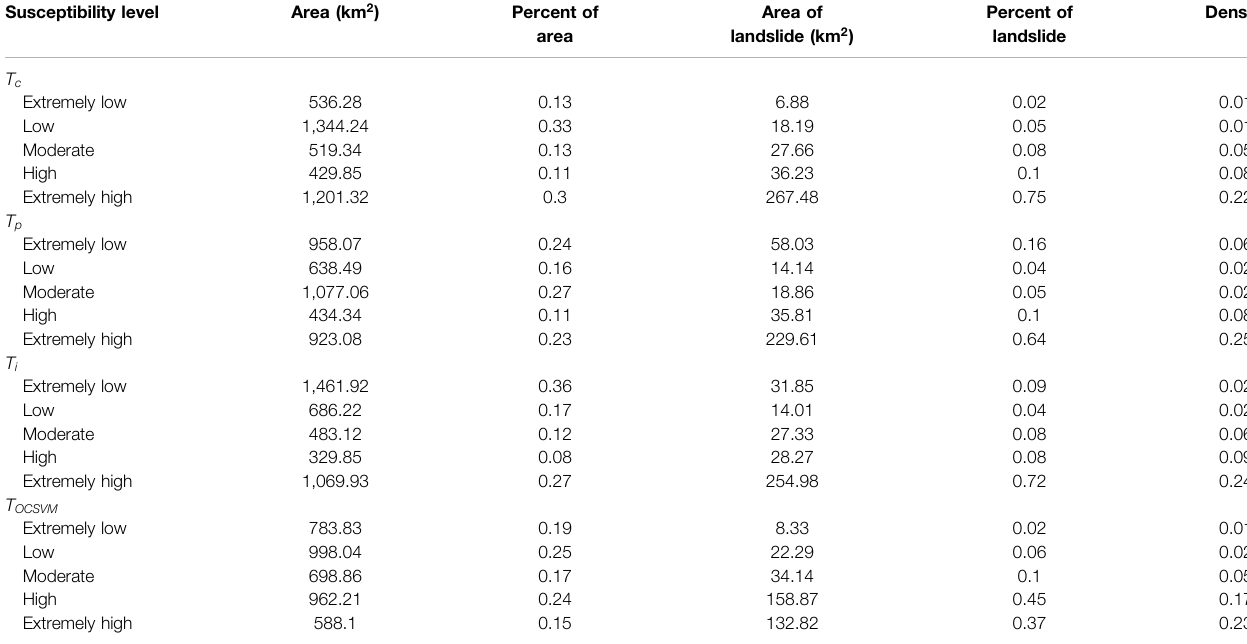
TABLE 3 | Landslide susceptibility levels and density of landslides in the study